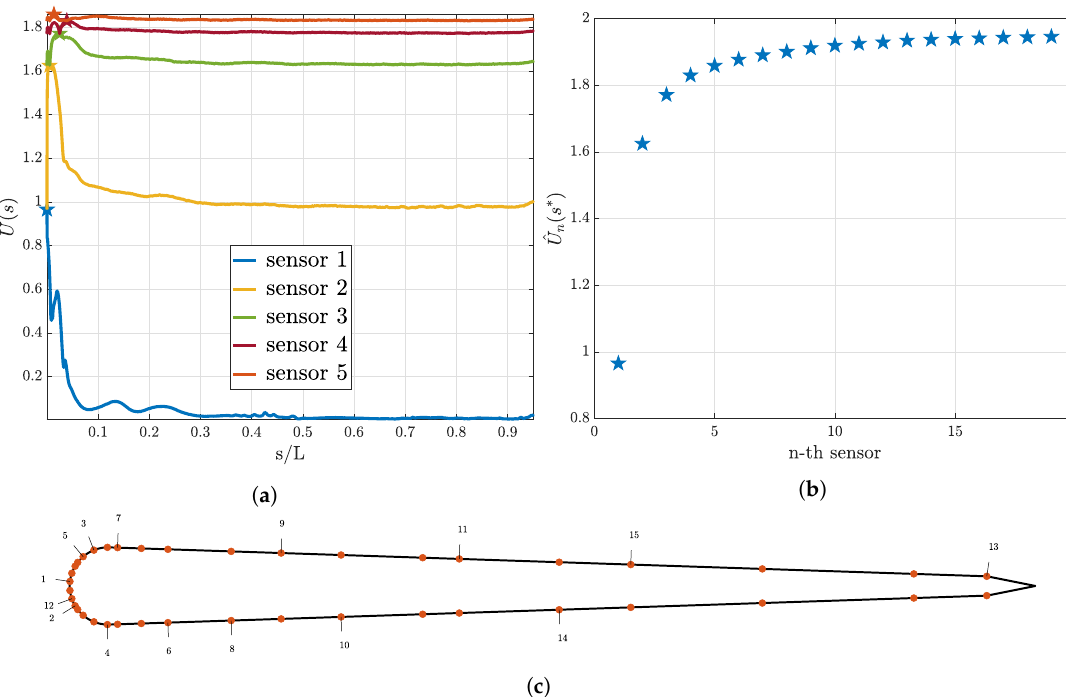
Figure 5. Optimal sensor placement for the pressure sensors and the “size of the leading school” experiment. In ( a ) the utility estimator for the first five sensors and in ( b ) the value of the utility estimator at the optimal sensor location for the first 20 sensors are presented. In ( c ), the distribution of the sensors on the swimmer surface is presented. Here, the numbers associated to each sensor indicate that this location is the i -th sensor location chosen according to Equation